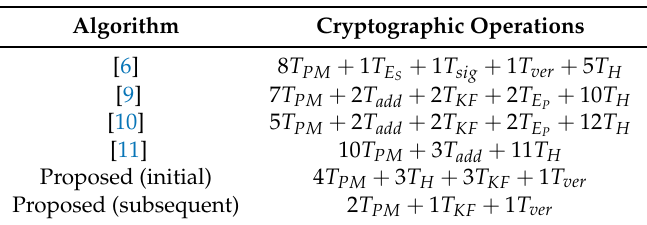
Table 4. Computational operations of various algorithms.